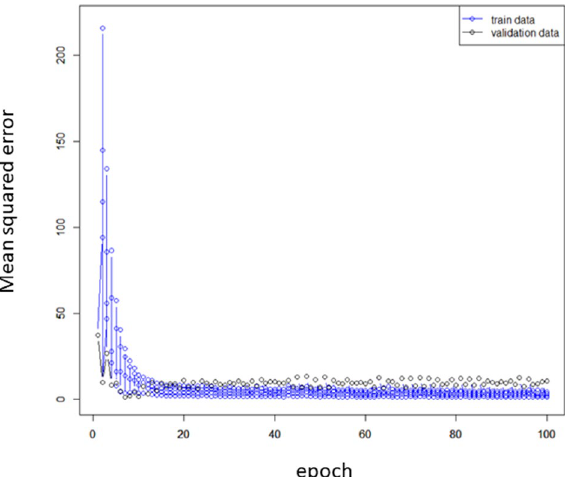
Figure 1. The mean squared error, of the DL model, with the validation dataset at each epoch. The mean squared error saturated at < 100 epochs.